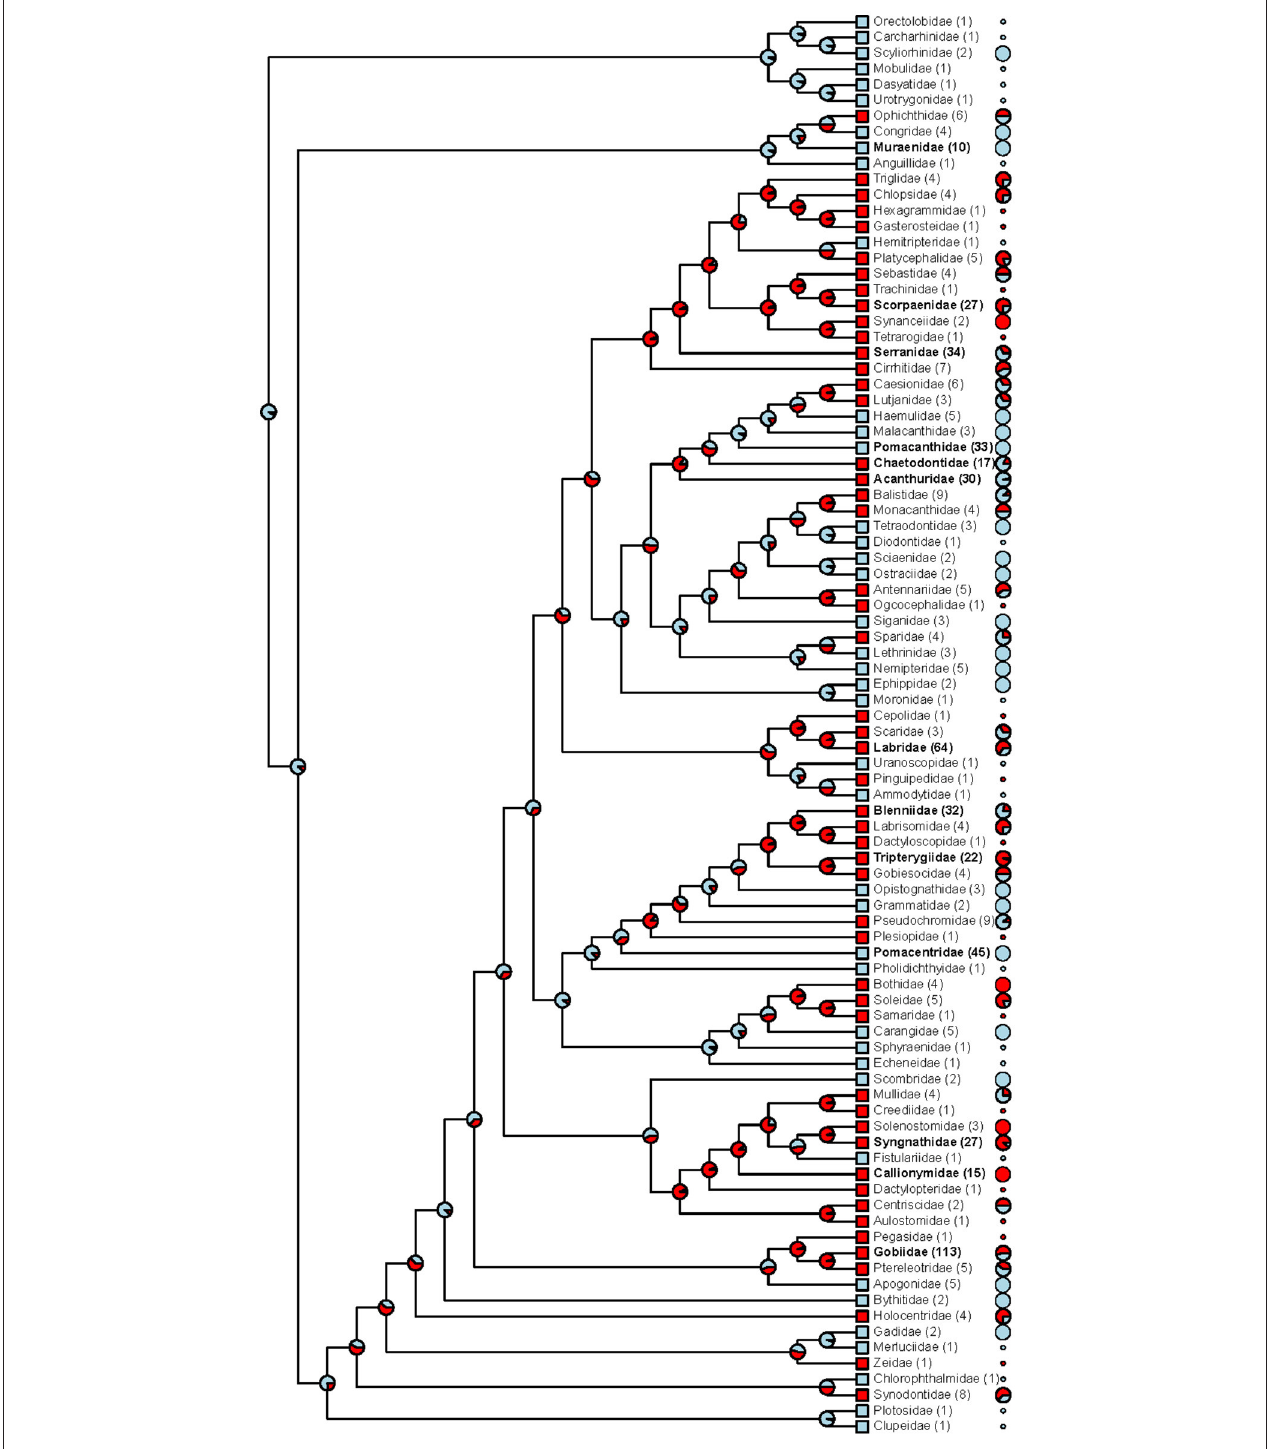
FIGURE 5 | Phylogenetic distribution of red fluorescence among marine fish families. For each family, tip labels show (i) whether fluorescence has been confirmed in at least a single species (red squares vs. blue squares), (ii) the total number of investigated species (in brackets; families with ≥ 10 species in bold face), and (iii) the proportion of species that exhibit red fluorescence (pie charts; shown for families with ≥ 2 species). At each node, the maximum likelihood for red fluorescence being the ancestral state is indicated by the red pie portion.